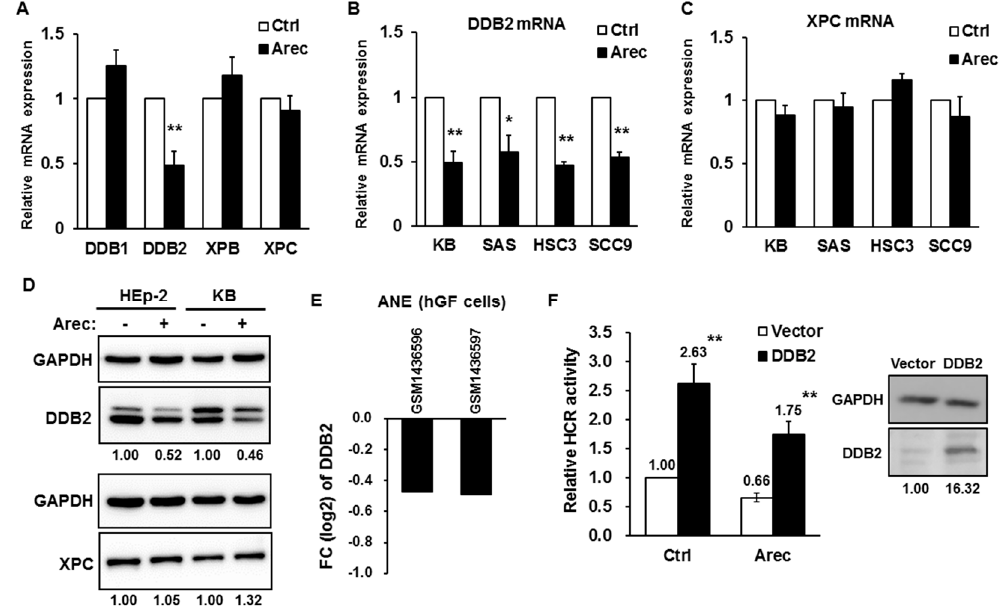
Figure 1. Arecoline specifically downregulates the expression of DDB2. ( A ) RT-qPCR showed that arecoline treatment (0.3 mM, 24 h) decreased DDB2 mRNA level in HEp-2 cells. The mRNA levels of DDB1 , XPB , and XPC were not affected apparently. The relative mRNA expression in vehicle control (H 2 O) was set as one by using GAPDH as an internal control. ( B ) RT-qPCR showed that DDB2 mRNA level was downregulated in arecoline treated KB, SAS, HSC3, and SCC9 cells. ( C ) The mRNA expression of XPC was not affected by arecoline treatment in KB, SAS, HSC3, and SCC9 cells. ( D ) Western blot analyses showed that arecoline treatment (0.3 mM, 24 h) decreased DDB2 protein level in HEp-2 and KB cells. The protein level of XPC was not affected. ( E ) The expression of DDB2 mRNA was downregulated in ANE-treated human gingival fibroblasts (hGF). The results were extracted from the Gene Expression Omnibus (GSE59414) and the expression level of DDB2 mRNA was log2 transformed. FC, fold-changed (ANE versus H 2 O). ( F ) Host cell reactivation (HCR) assay showed that overexpression of DDB2 restored arecoline-mediated inhibition of nucleotide excision repair in HEp- 2 cells. The expression of flag-tagged DDB2 was detected by Western blot analysis using an anti-flag antibody. All data are shown as mean ± standard deviation ( n = 3–5). Ctrl, vehicle control (H 2 O); Arec,